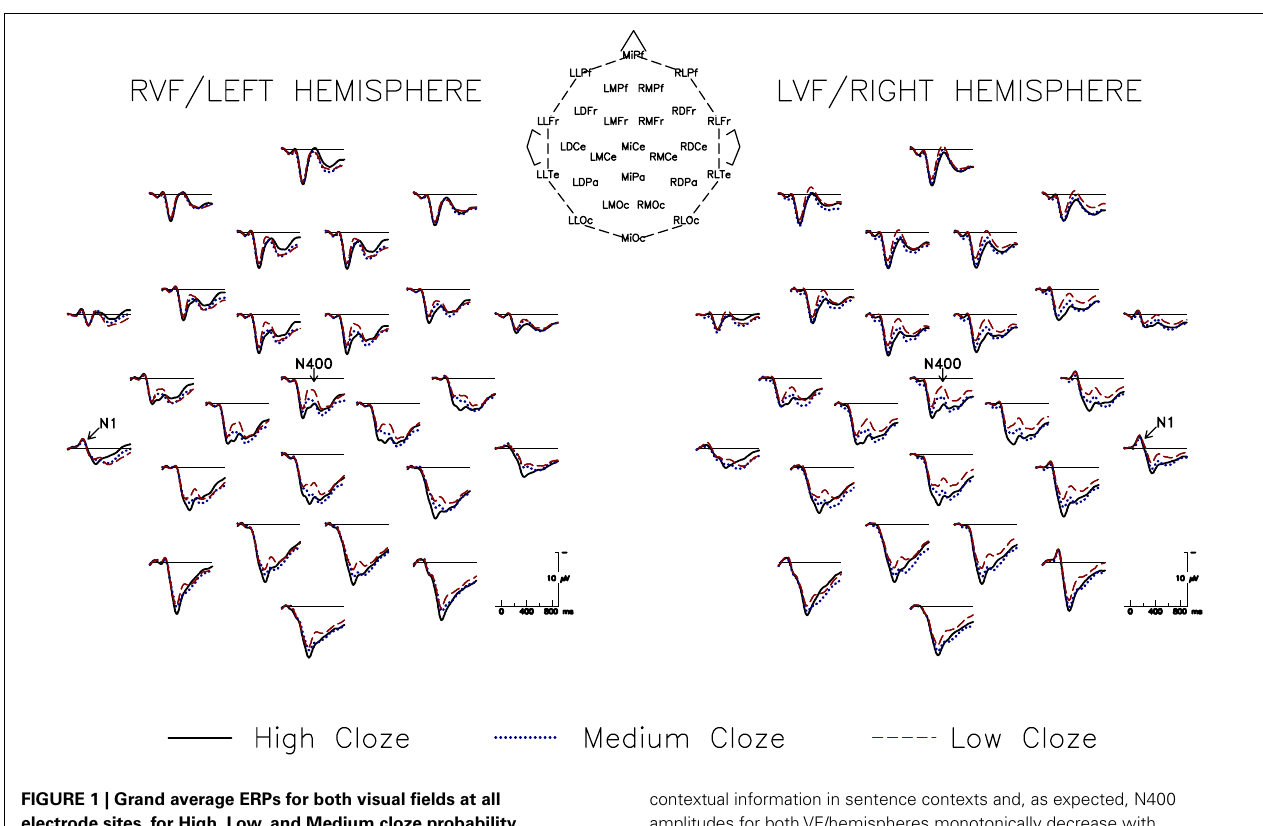
FIGURE 1 | Grand average ERPs for both visual fields at all electrode sites, for High, Low, and Medium cloze probability sentence completions. Both hemispheres are sensitive to